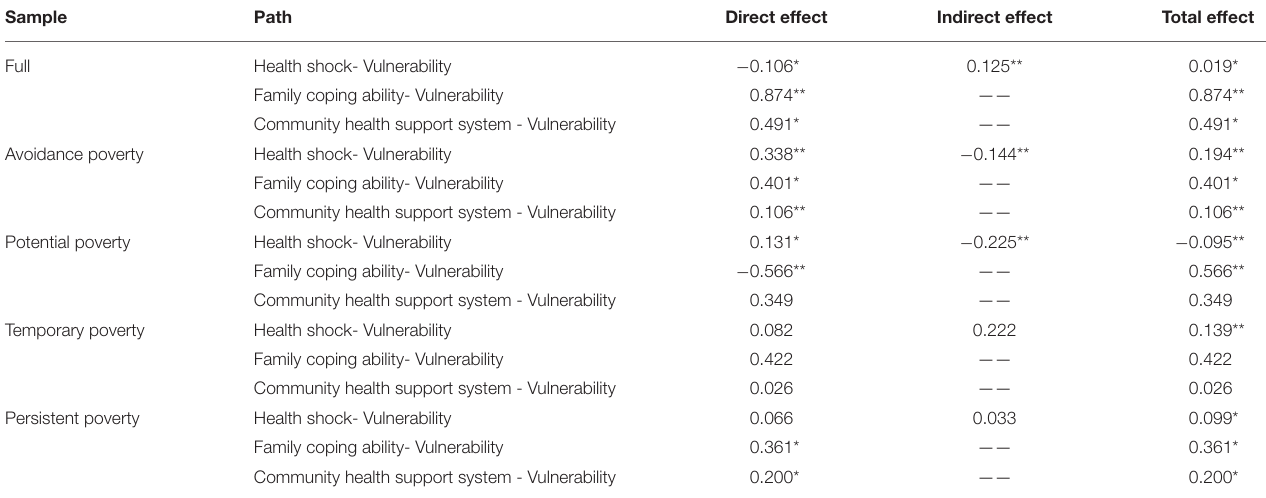
TABLE 4 | Standardized effect statistics